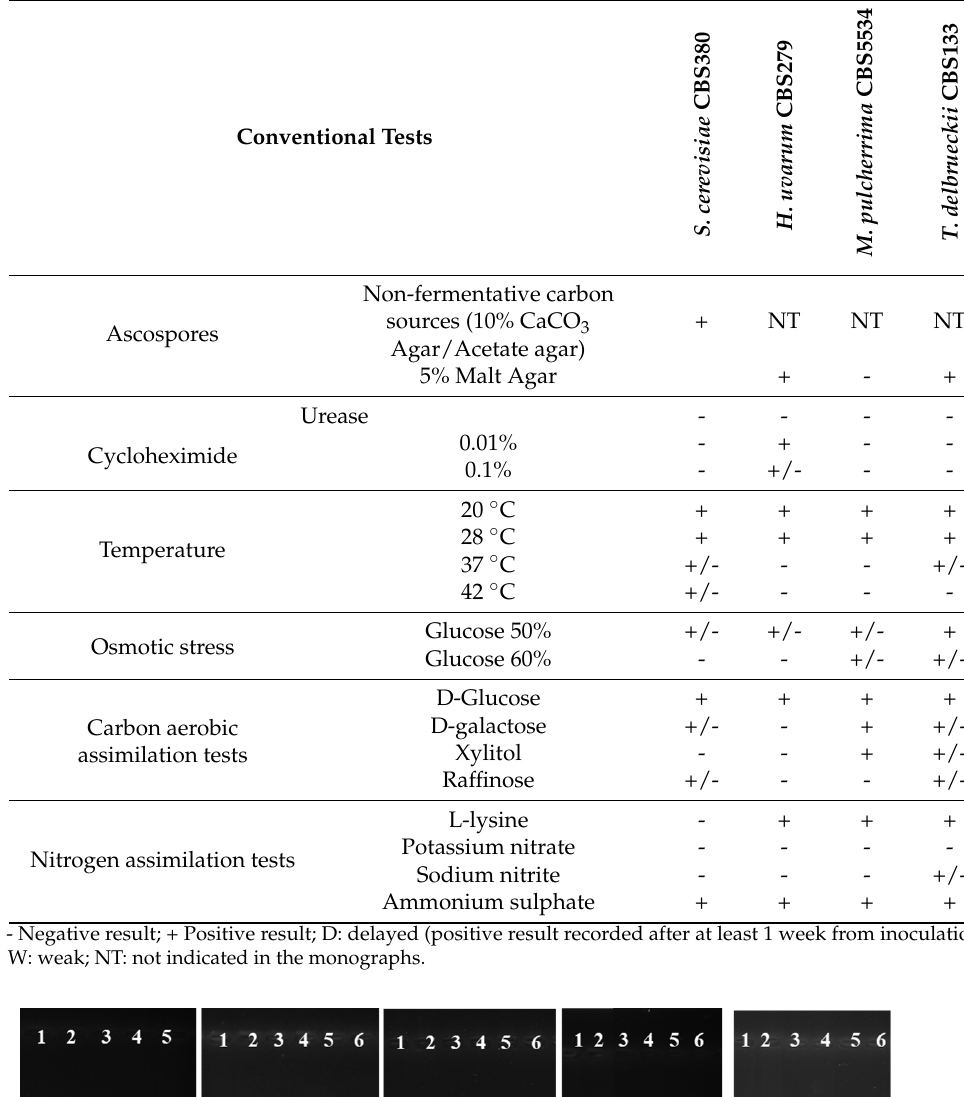
Table 2. Conventional taxonomy test results for reference strains [18,20].